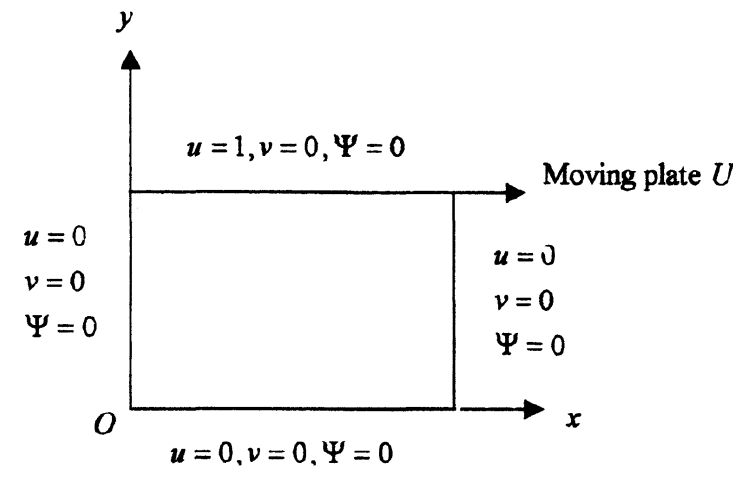
Figure 1. Schematic of the cavity